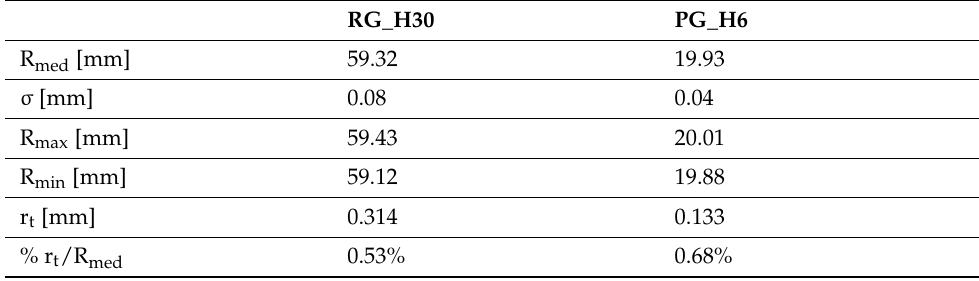
( b ) PG vs. CAD punch fillet radius Figure 7. Main results of cup LP analysis. Table 5. Punch height measured after the deep drawing process. RG